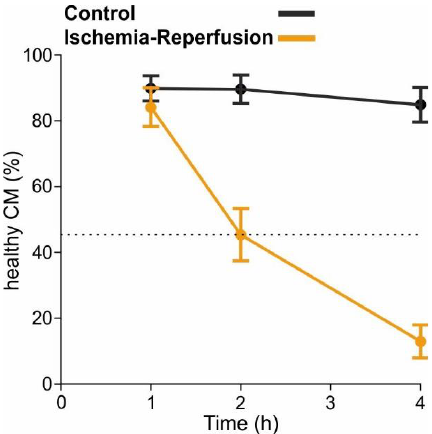
Figure A2. Survival of cardiomyocytes decreased with prolongation of ischemia time. Percentage of healthy CM at the end of the cellular model for IR with 1, 2, or 4 h of ischemia followed by 30 min of reperfusion. Dots show the mean survival ± 95% CI (calculated independently for each group), with yellow indicating IR and black control conditions. Dotted line indicates 45%, which is half the survival of CM in control conditions.